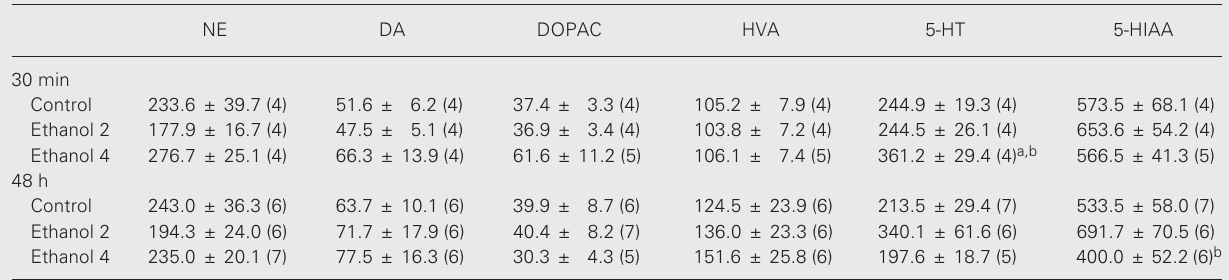
Table 1. Effects of chronic ethanol treatment on concentrations of monoamines and metabolites in the rat